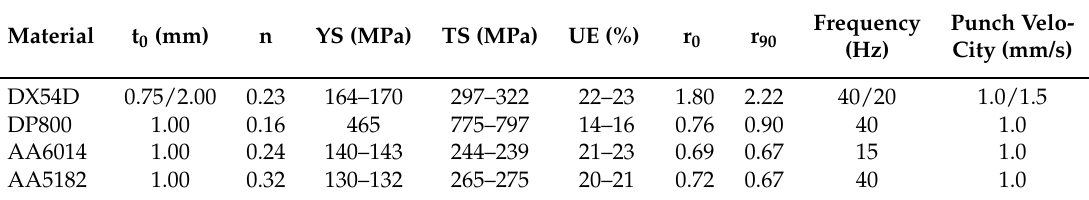
Table 1. Material properties of the investigated materials [13] including